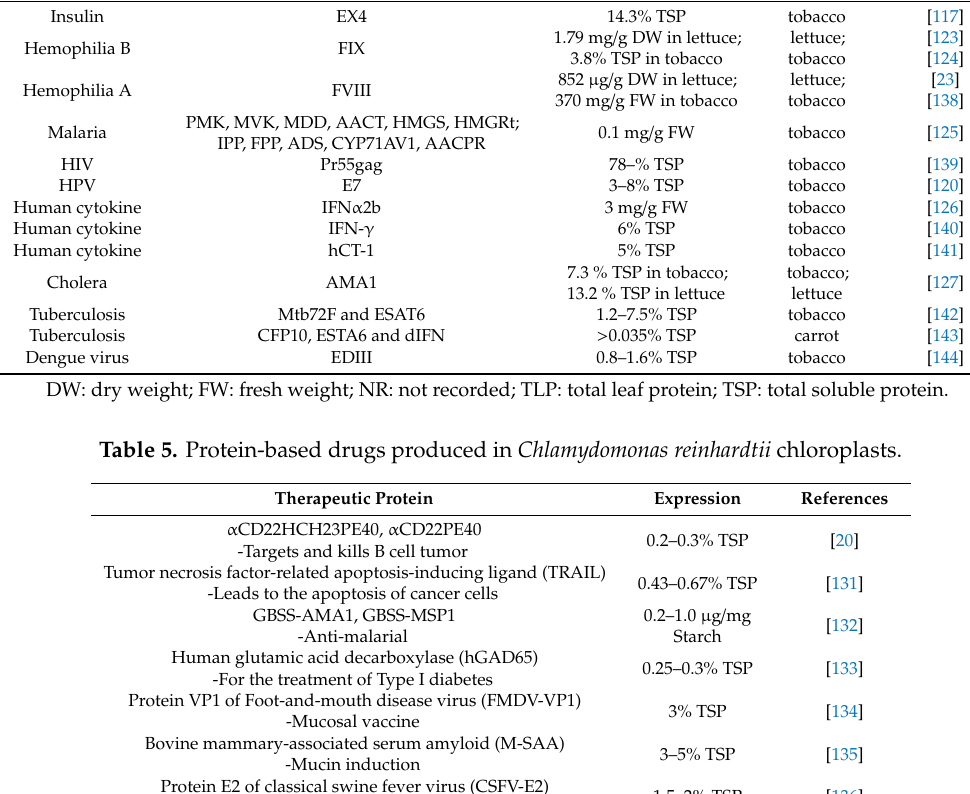
Table 4. Vaccine antigens and protein-based drugs produced by chloroplasts. Trait